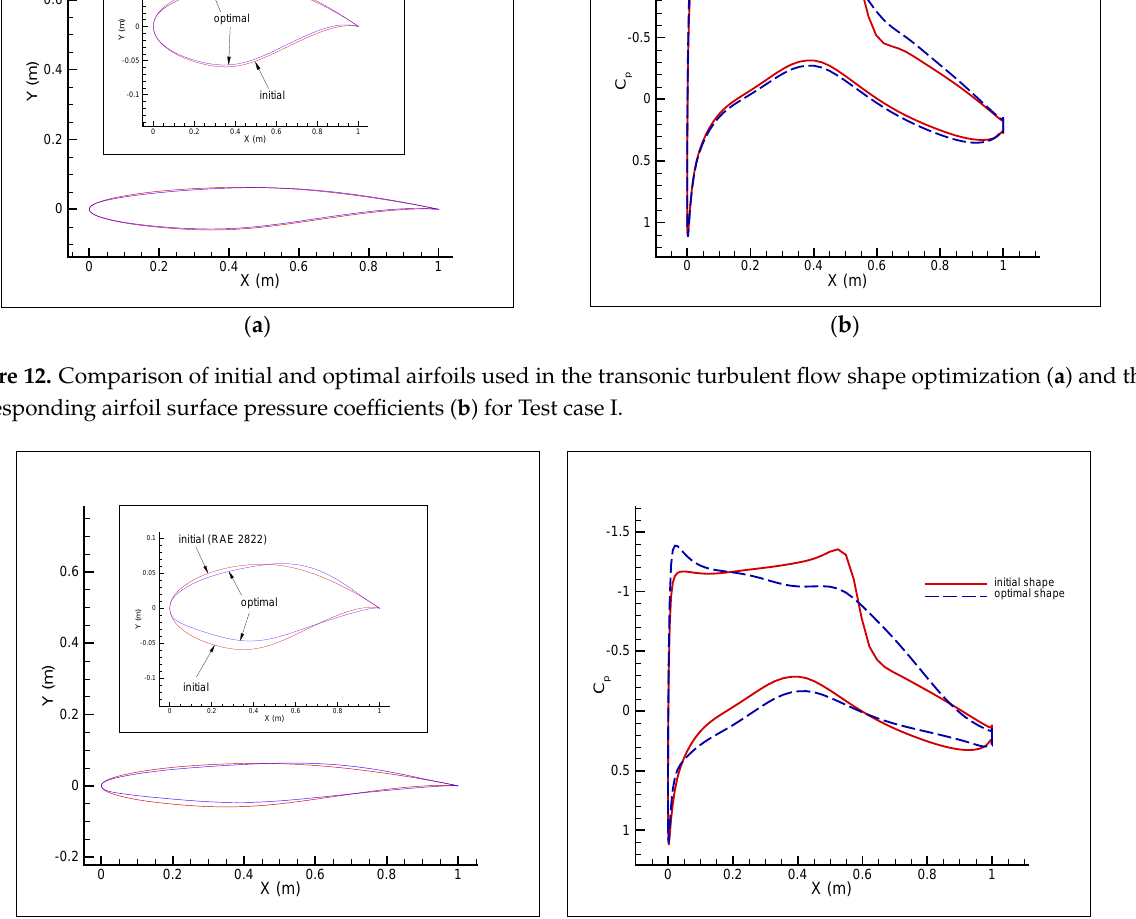
Figure 13. Comparison of initial and optimal airfoils used in the transonic turbulent flow shape optimization ( a ) and the corresponding airfoil surface pressure coefficients ( b ) for Test case II.